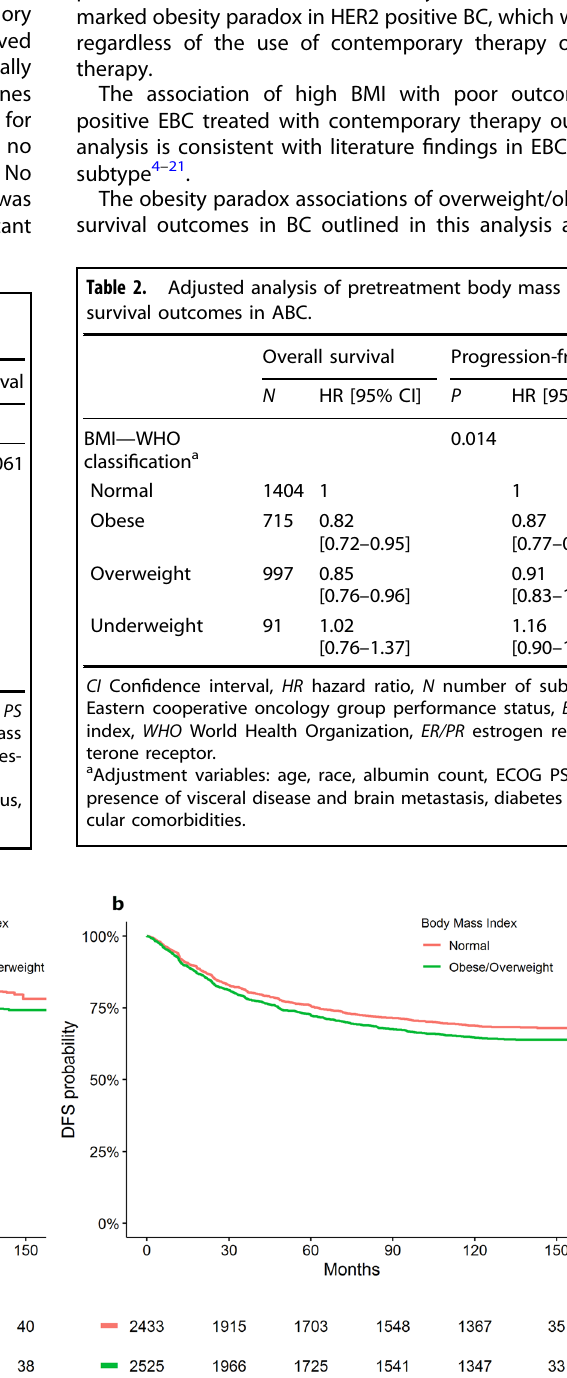
Fig. 1 Kaplan – Meier plot representing survival outcomes by BMI status in early breast cancer [Data from HERA study]. a Overall survival; b disease-free survival.